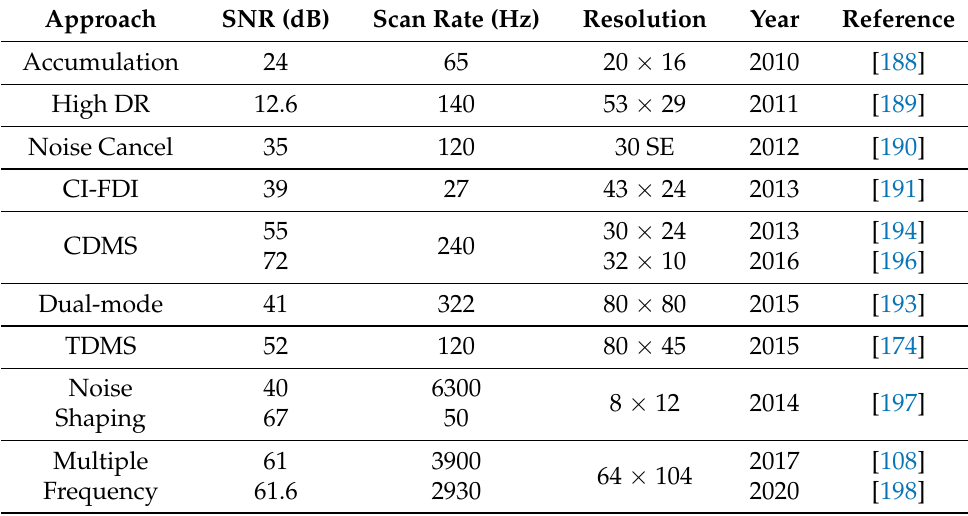
Table 2. Specification comparison of capacitive touchscreen